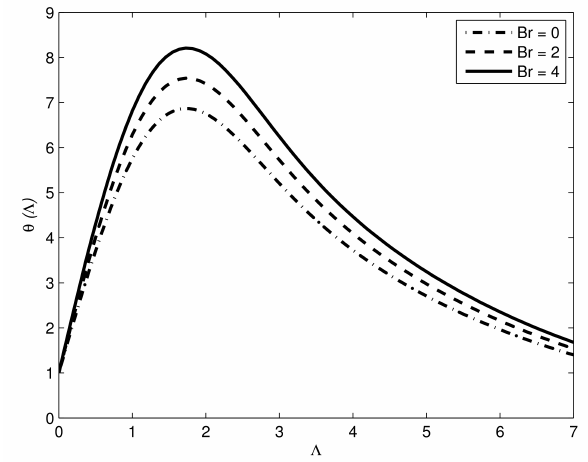
Figure 18: Effect of Br on θ ( Λ ) keeping ζ = 0.5 , η = 0.2 , C 1 = C 2 = C 3 = 100 , Pr = 6.8 , Re = 100